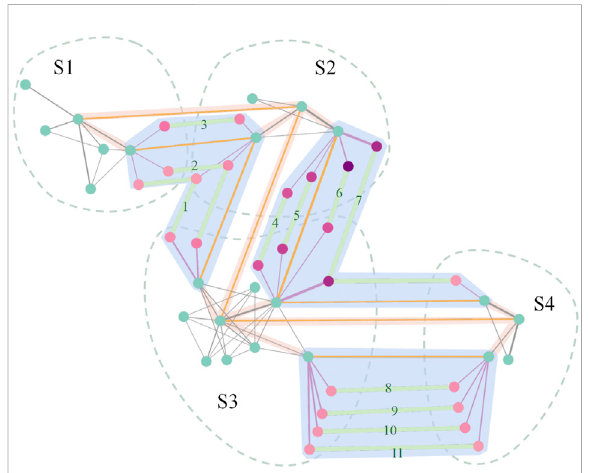
FIGURE 11 Coreevolutionnetwork.Therearetwotypesofverticesinthe network. Green vertices are the core modules, which are the modulescombining theglobal module network and the biological functional network with a degree ≥ 5. The pink vertices are the core biological functions that we obtained through GSEA, the selection of which is related to the core modules: the darker the color is, the smaller the q -value of the biological functions. The cycles with a dotted line represent the stages of the disease, and the vertices in the cycle represent the core modules and core biological functions in the stage. There are three types of edges. Edges in gray connect the modules in each stage or between the core modules and core biological functions. Edges in orange connect core modules in the two stages with the Jaccard coef fi cient ≥ 0 . 1. Edges in light green connect the core biological functions, which represent the evolution of the biological functions, and the numbers on the edges represent the serial number of the core biological functions. The blue background highlights the evolution of the biological functions and the corresponding11corebiologicalfunctions,whichareasfollows:1. B-cell differentiation; 2. B-cell activation; 3. B-cell receptor signaling pathway; 4. neutrophil chemotaxis; 5.